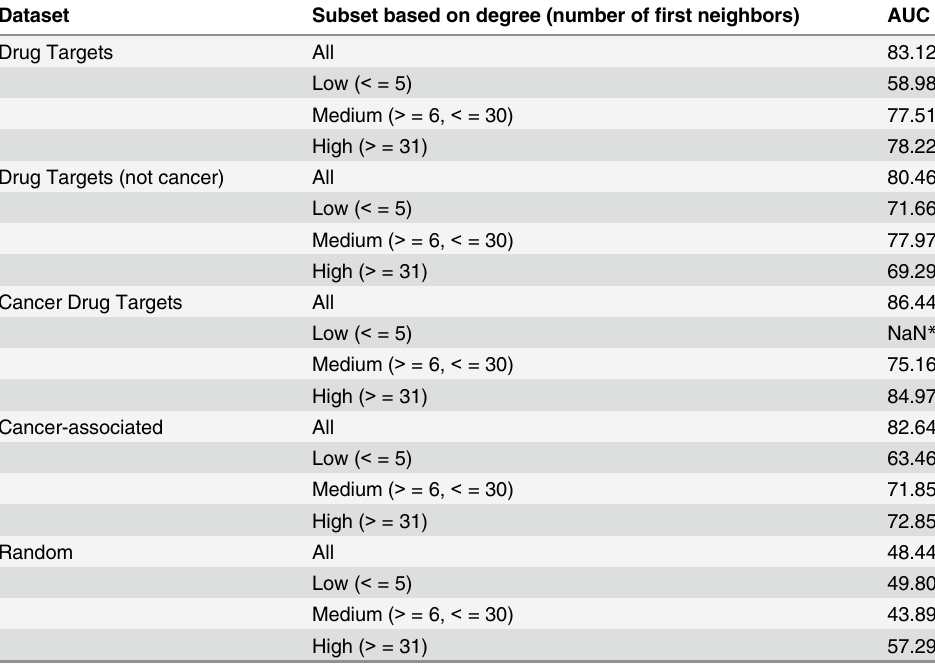
Table 1. Results of the 10-fold cross-validation of predictive